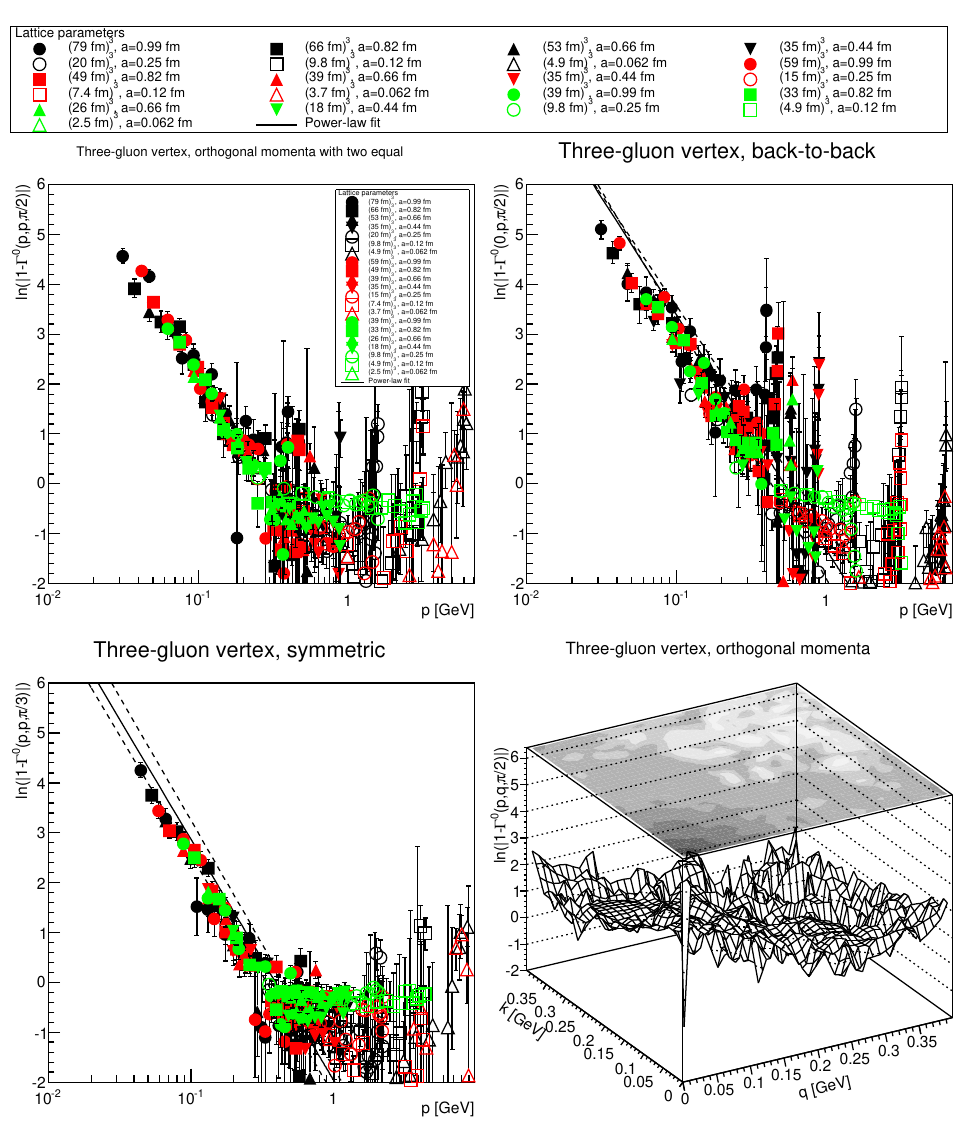
Figure 2: The three-gluon vertex tree-level form factor in three dimensions plotted as ln | 1 − Γ 0 | The top-left panel shows a cut along the diagonal of the lower-right plot. The latter shows the situation with two momenta being orthogonal to each other, with interpolation of the data points for the largest volume at the coarsest discretization. The top-right panel shows the back-to-back momentum configuration and the bottom-left panel the symmetric momentum configuration. Only points with a relative error of less than 100% are shown, and the lowest momentum point is suppressed. The fit (4) shown is the extrapolated one in the symmetric configuration (bottom-left panel) and in the back-to-back configuration (top-right panel), see text. settings. The infinite-volume-extrapolated results for the back-to-back configuration and the symmetric configuration